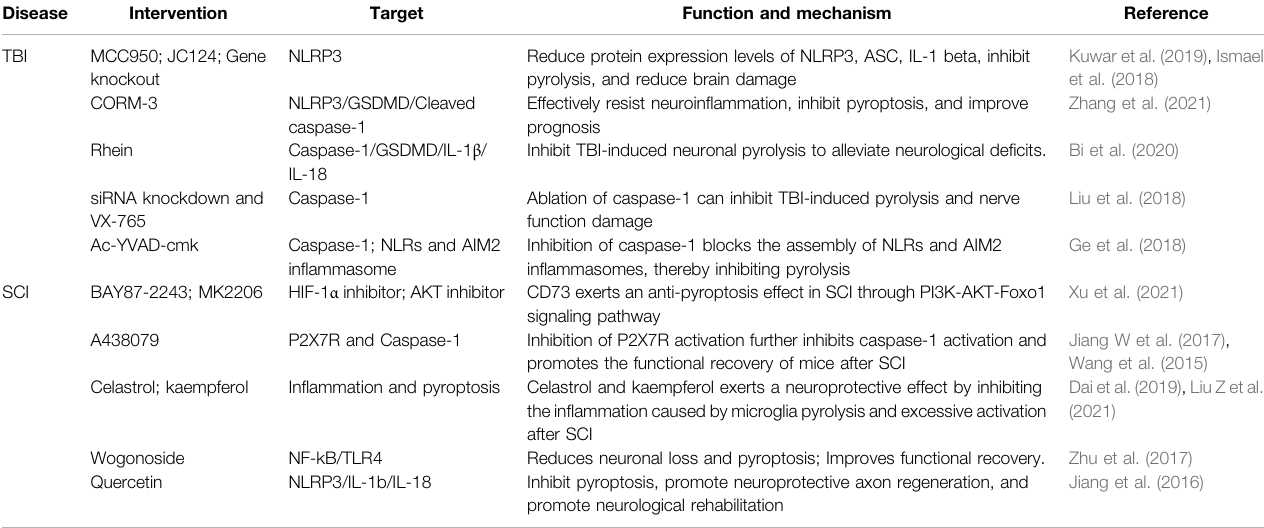
TABLE 2 | The role of pyroptosis in CNS